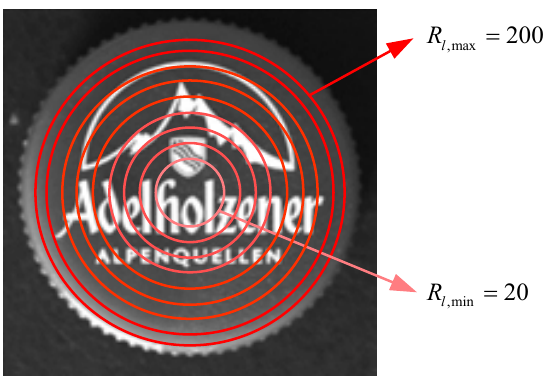
Figure 4. An example to illustrate the circular region of hybrid projection calculation.